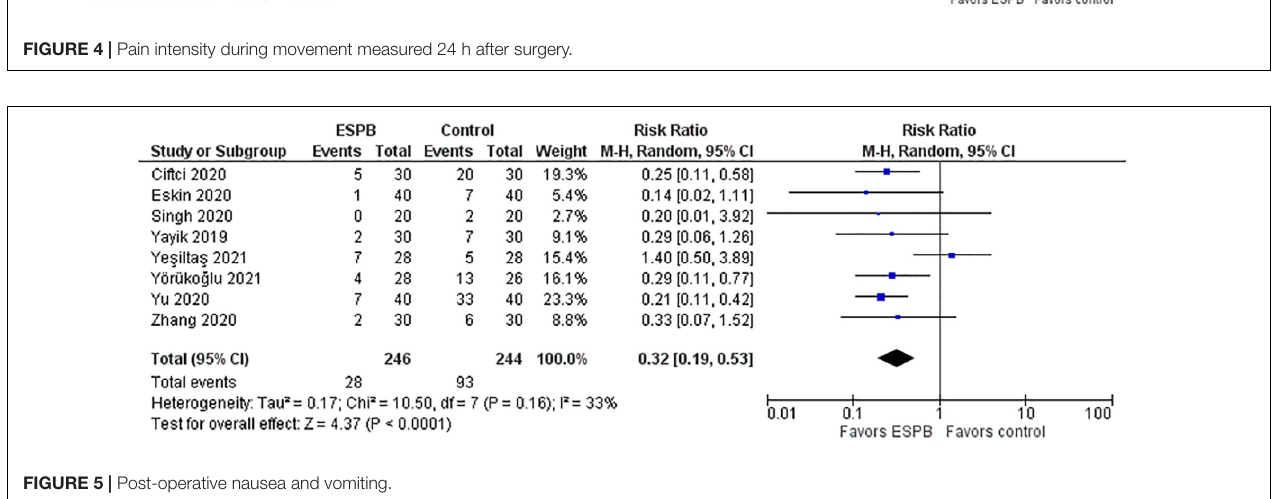
FIGURE 5 | Post-operative nausea and vomiting.